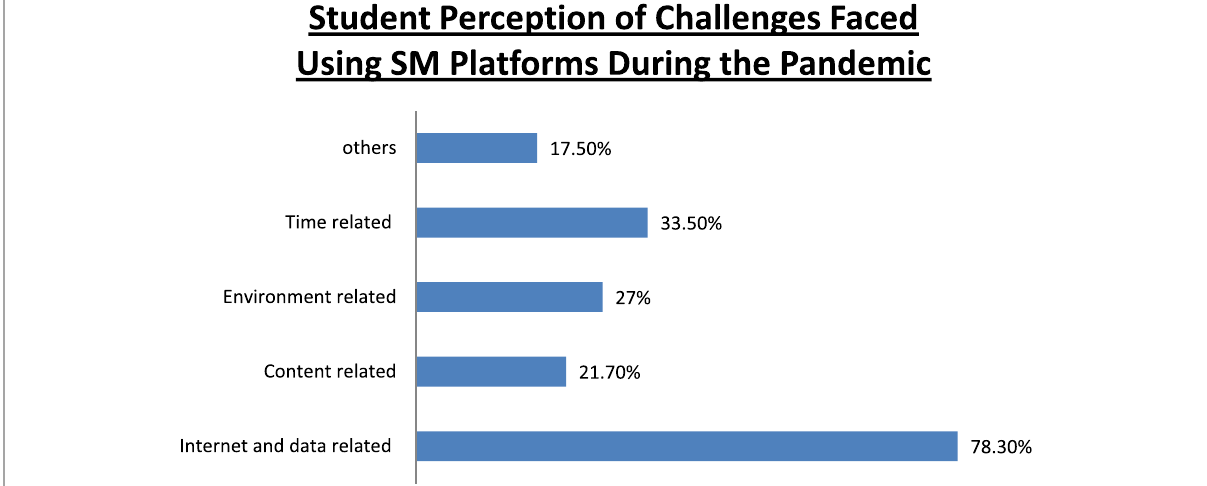
Fig. 2 Student perception of challenges faced using SM platforms during the pandemic